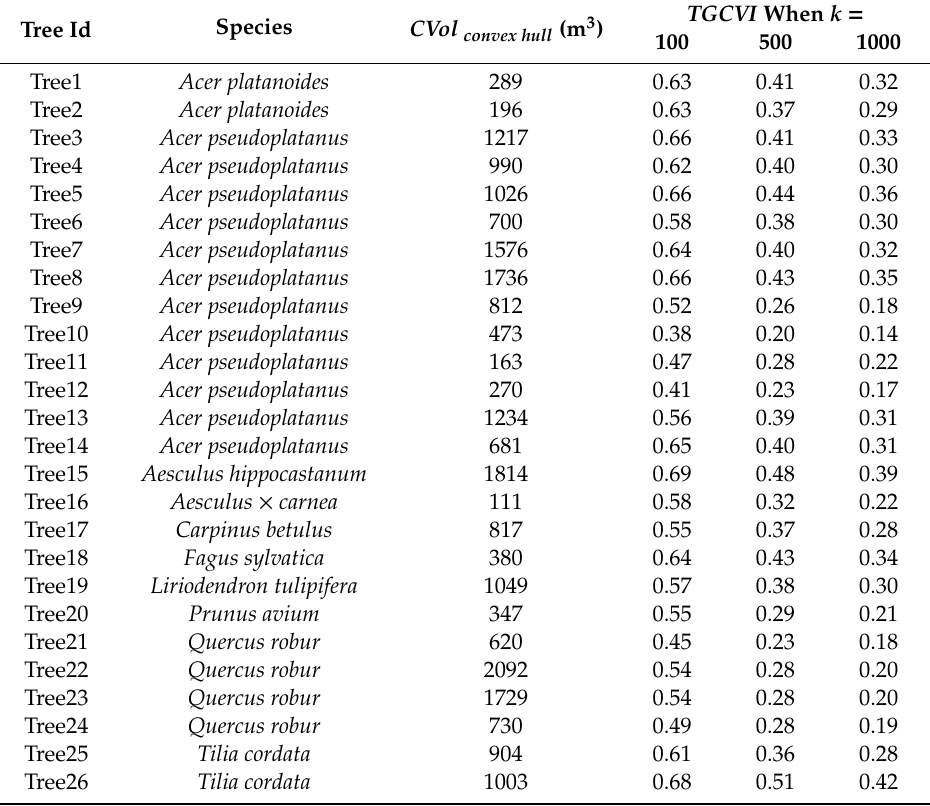
Table 3. The sample trees and their tree green crown volume